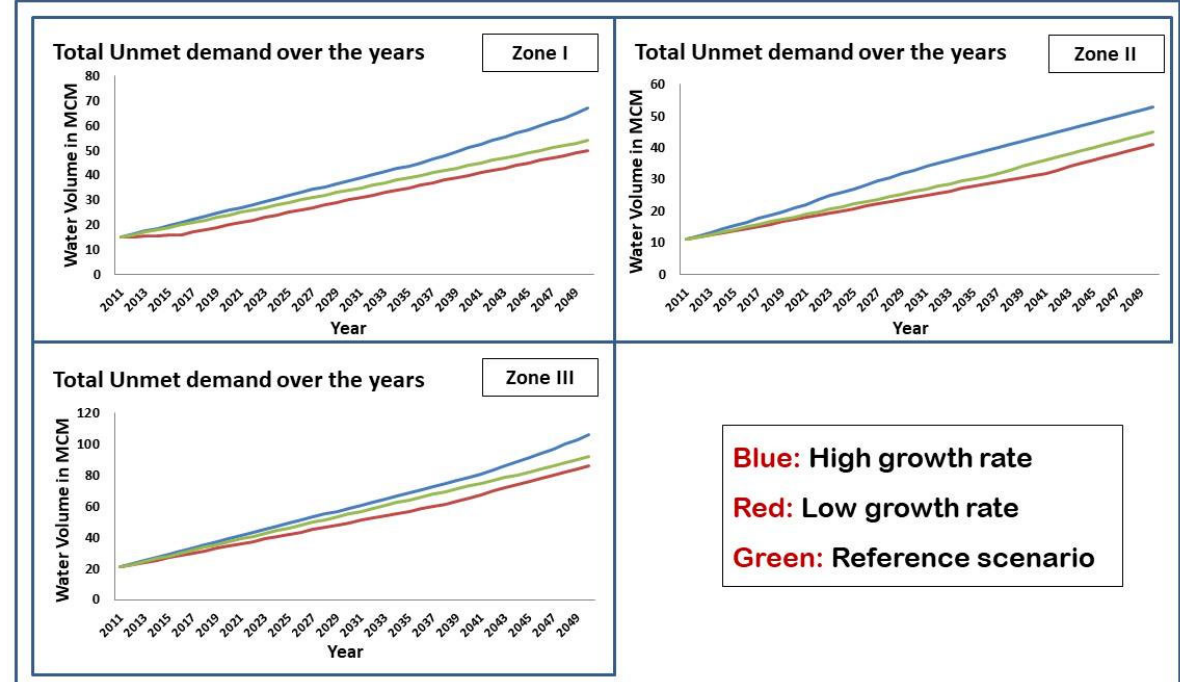
Figure 10. Zone-wise unmet demand under different Figure 10. Zone ‐ wise unmet demand under different scenarios.